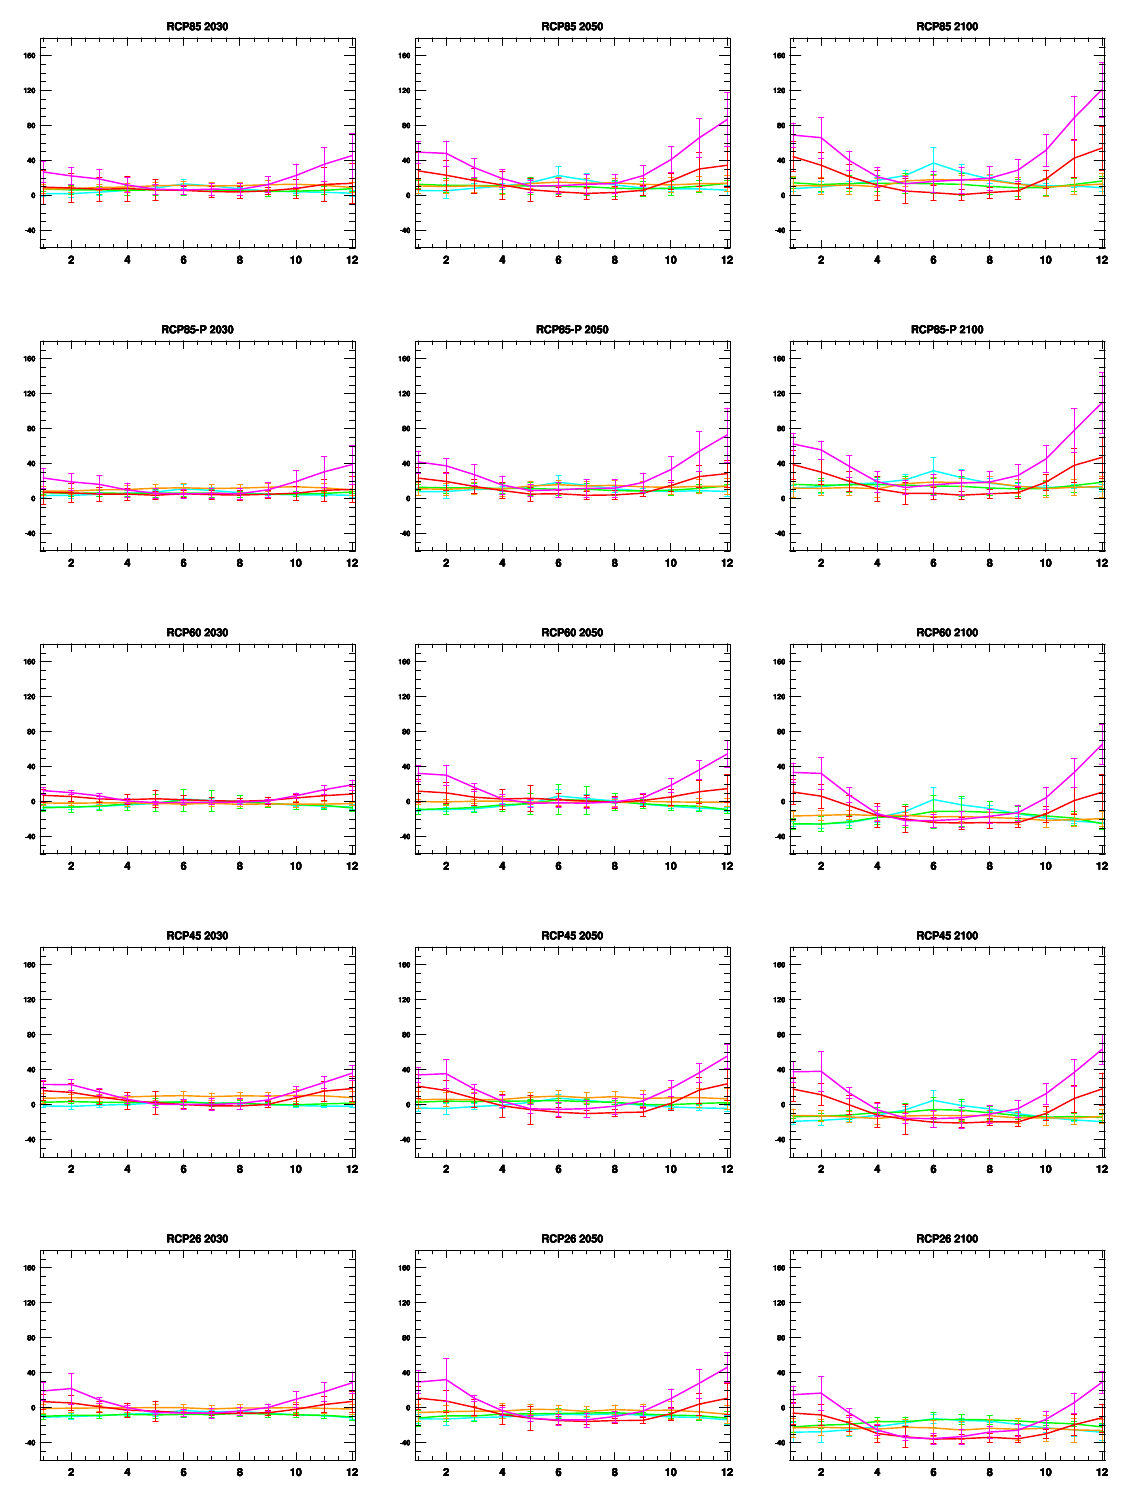
Fig. 7. Percentage difference in the seasonal cycles of monthly average surface ozone mixing ratio in megacity grid cells compared with the 2005 base run. Left to right: years 2030; 2050; and 2100. Top to bottom: RCP-8.5; RCP-8.5-P; RCP-6.0; RCP-4.5; and RCP-2.6. Lines for each latitude band are coloured as in Fig. 6.